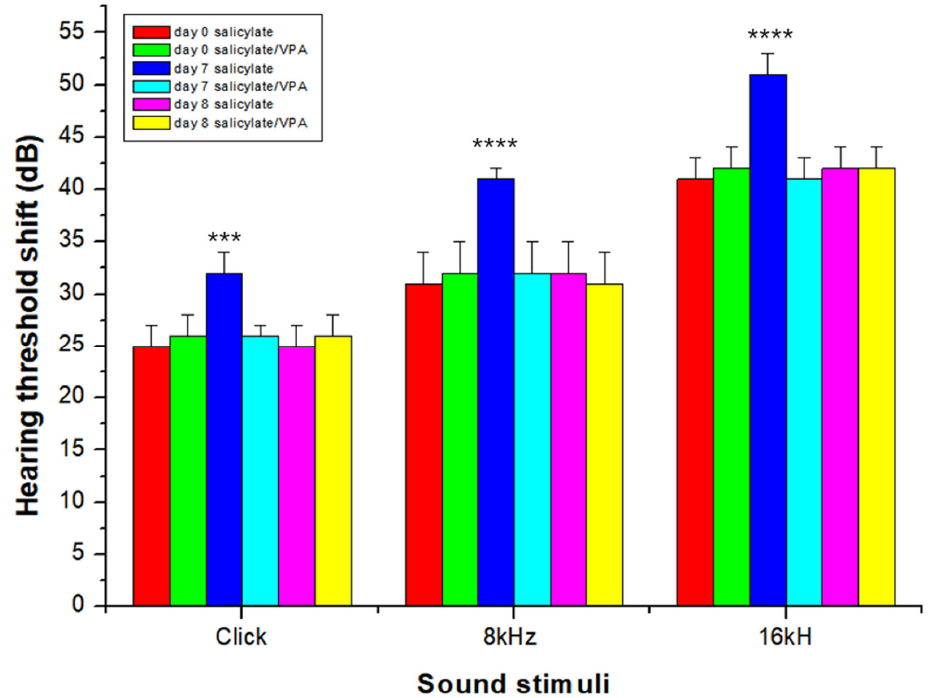
Figure 6. Statistically significant temporary ABR threshold shift was observed in the salicylate group on day 7 compared with ABR threshold shift before treatment (click, *** p < 0.001; 8 kHz, **** p < 0.0001; 16 kHz, **** p < 0.0001). One ‐ way ANOVA followed by post hoc Tukey test using GraphPad Prism 8.0.